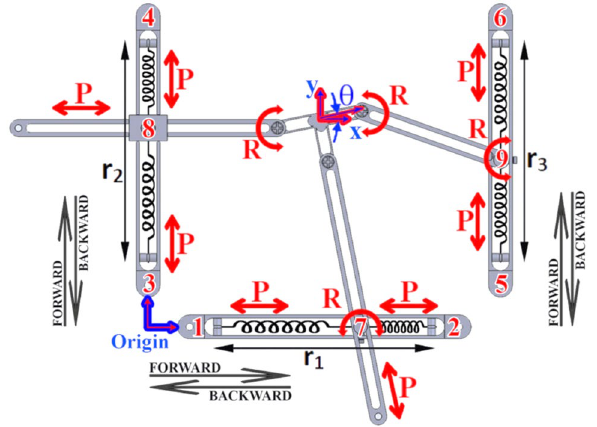
Fig. 4 PRP-PPR-PRR manipulator